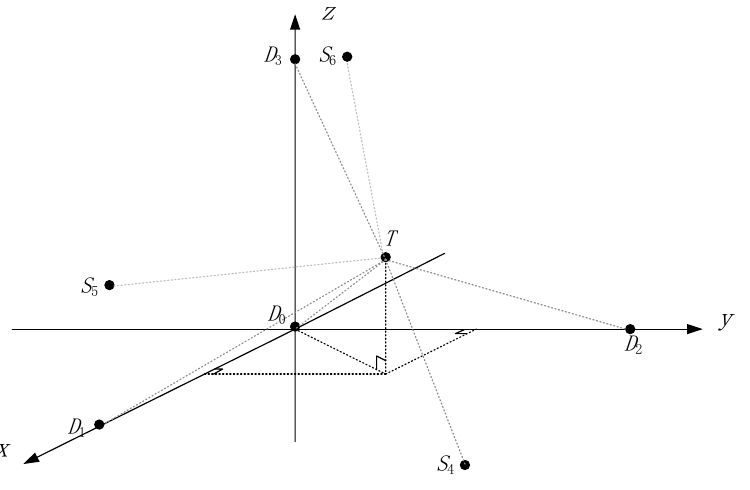
Figure 1. Systematic scenario of hybrid source localization